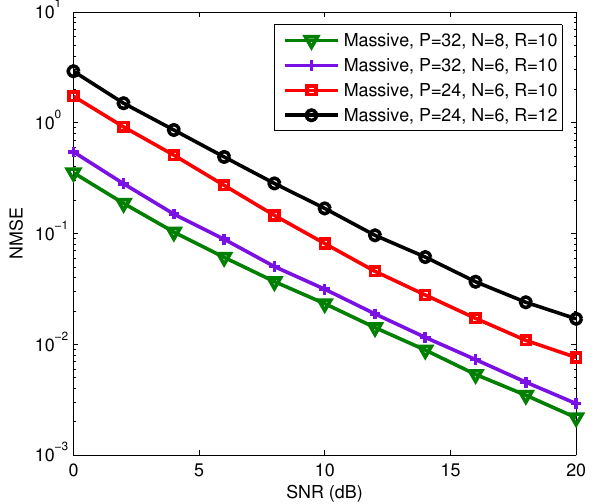
Figure 11. NMSE performance of the proposed receiver for the multi-user massive MIMO